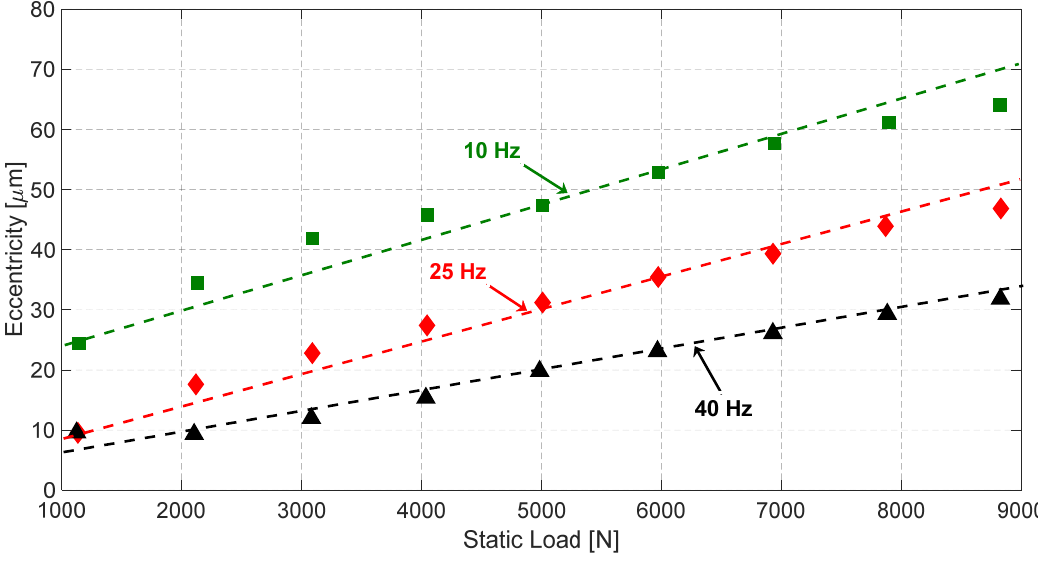
Figure 13. Eccentricity measurements at different shaft speeds vs. static load.